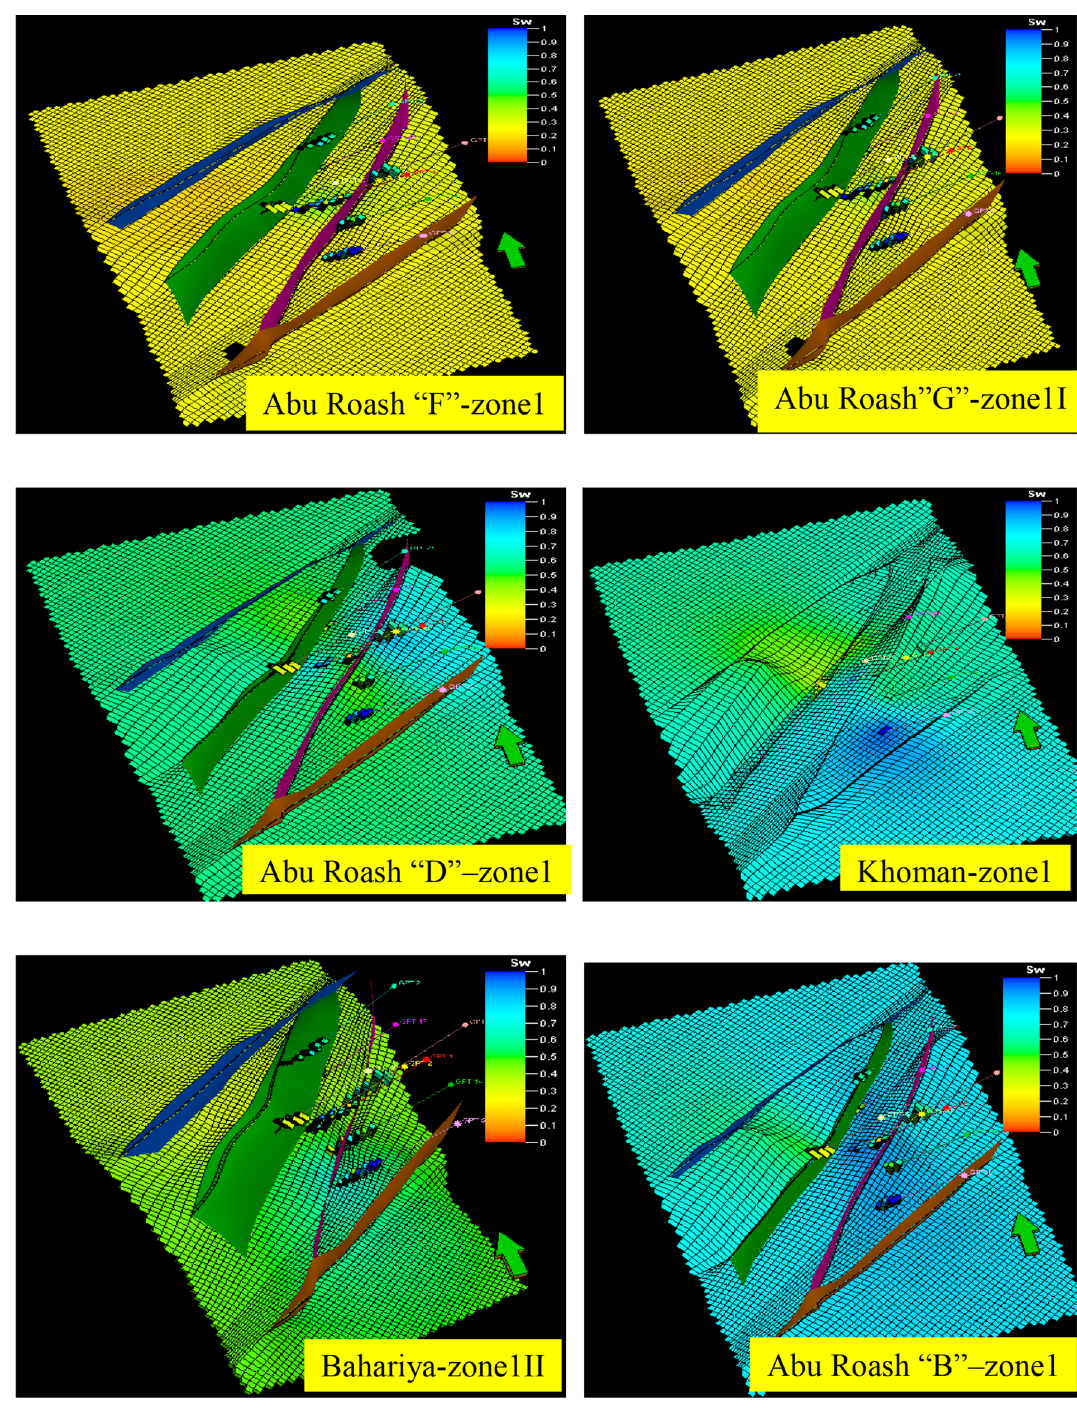
Fig. 18 Water saturation model example for the different pay